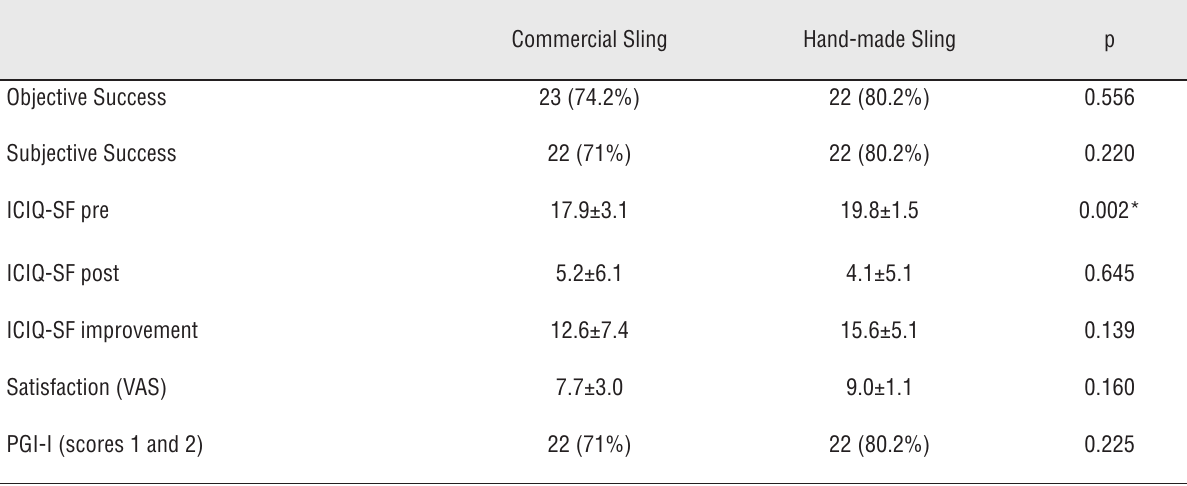
Table 5 - Success rates. Data expressed in (meanstandard deviation) or n